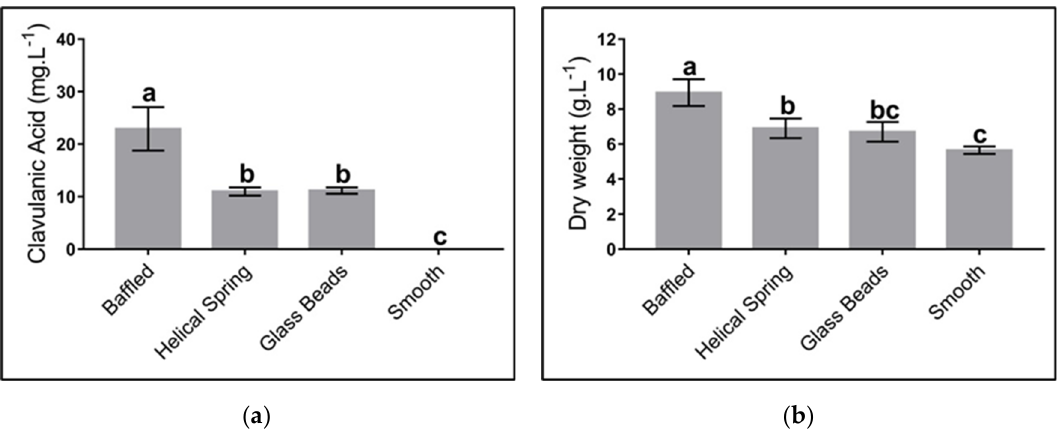
Figure 5. Effect of different flask geometries on the maximum clavulanic acid (CA) and biomass concentration in Streptomyces clavuligerus cultivations, using the complex culture medium: ( a ) CA; ( b ) biomass. All experiments were carried out under similar conditions. Letters a, b, and c indicate the groups generated through the least significant difference test (LSD). The same letter above bars means no significant differences among sources of mechanical stress.